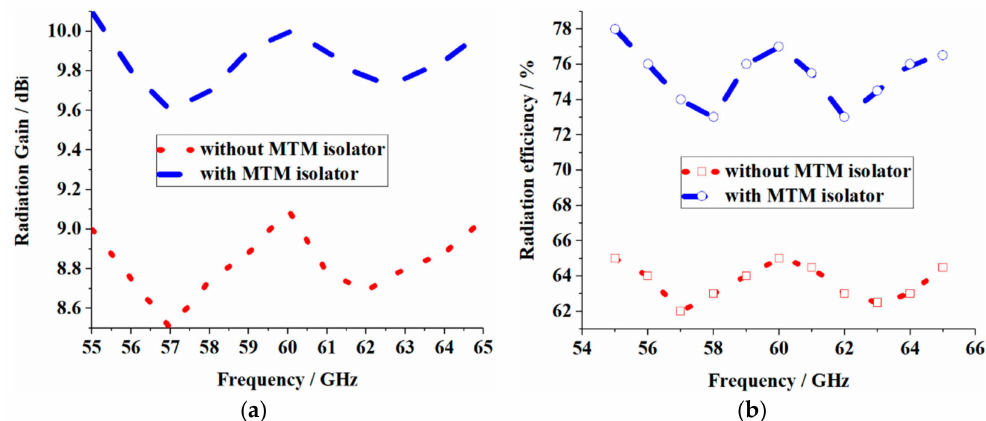
Figure 7. Radiation gain and e ffi ciency curves over frequency band for both cases with no and with